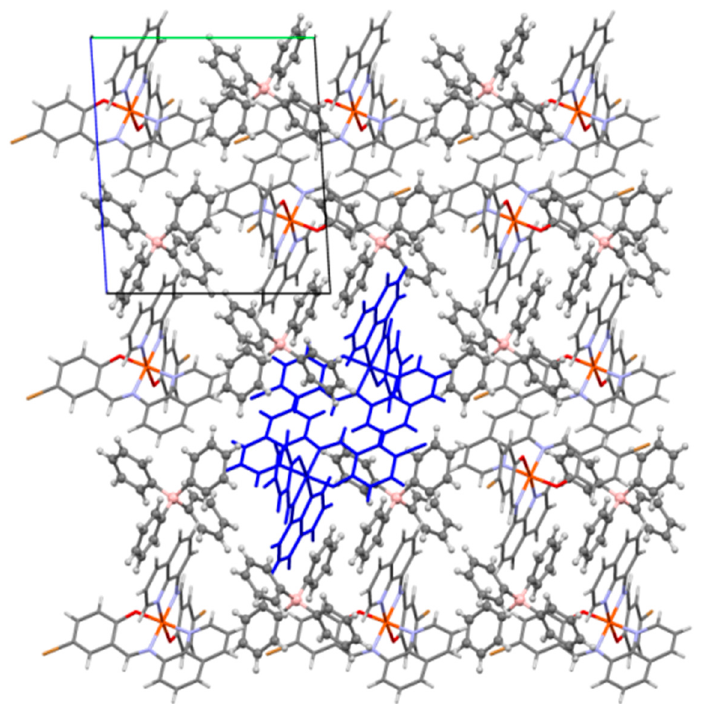
Figure 5. Top view of the crystal structure of 4.BPh 4 along the chain direction parallel to the a axis. The cations of one of the chains are depicted in dark blue. The cations of one of the chains are depicted in dark